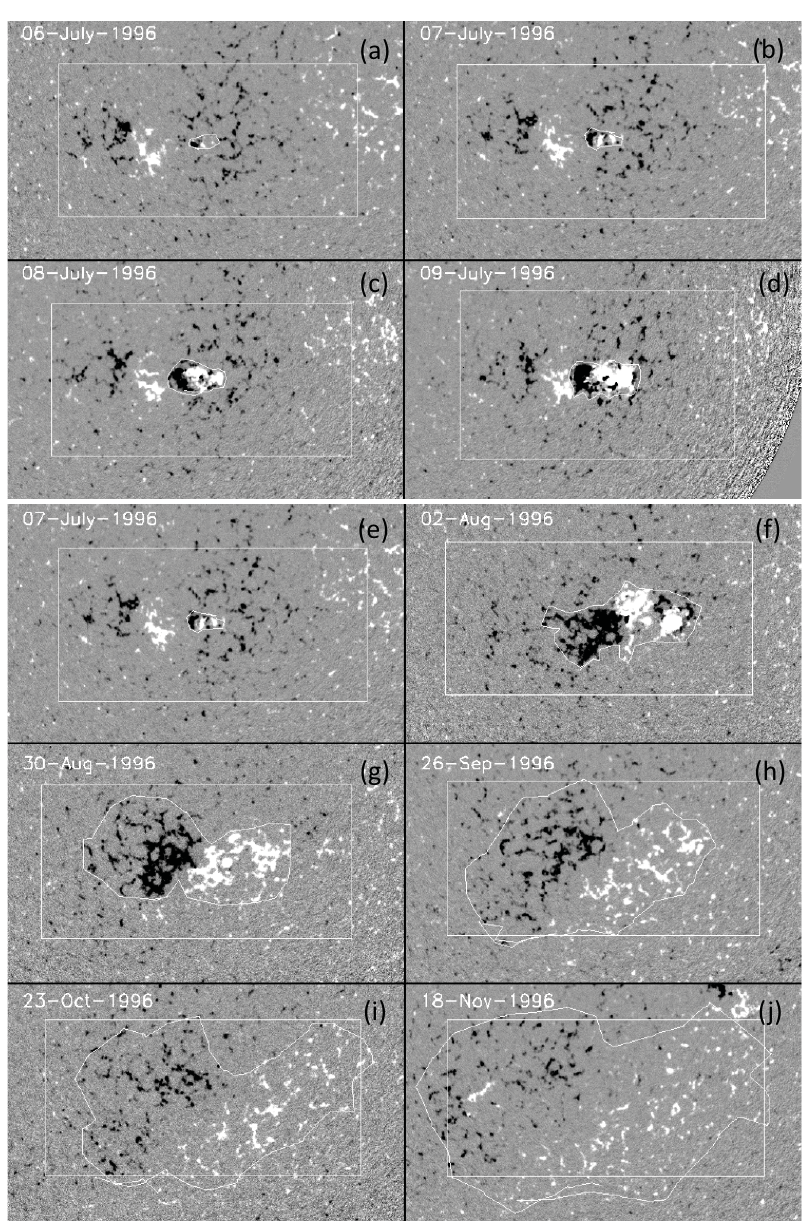
Figure 17: Magnetic maps of the emergence (a–d; 6 – 9 July 1996) and decay (f–j; July – November 1996) of AR NOAA 7978 as observed by SOHO/MDI. Contours outline the magnetic area of the AR. The rectangle around the AR has a fixed area of 1 . 6 × 10 11 km 2 . Magnetic flux was measured over both sets of areas (cf. Figure 18). (a)–(d) Daily maps of the emergence phase between 6 – 9 July 1996. Note that the AR emerged within a dominantly negative polarity area. (e)–(j) show the evolution of NOAA AR 7978 during six solar rotations around the times of CMP. Note that although this AR emerged into an active nest resulting in a complex magnetic configuration to start with and one further major flux emergence episode took place within its boundaries before it rotated onto the disc for the 2nd time, magnetic cancellation processes efficiently wiped out the complexity, keeping the structure of the AR dominantly